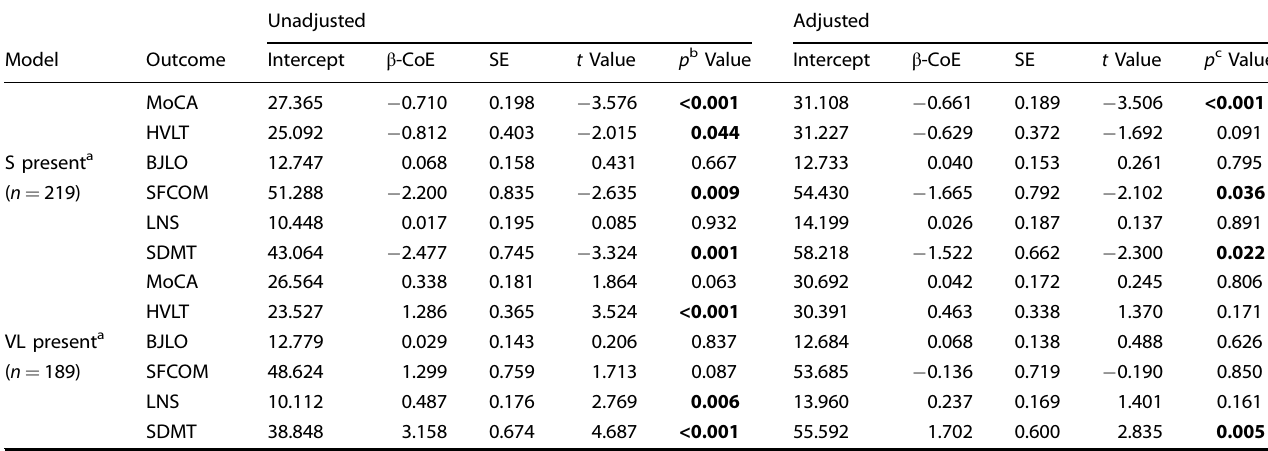
Table 2. Capacity of TOMM40 alleles in predicting cognitive performance over time, using unadjusted and adjusted generalised linear mixed models, in the sub-group of APOE ε 3/ ε 3 carriers within the PPMI